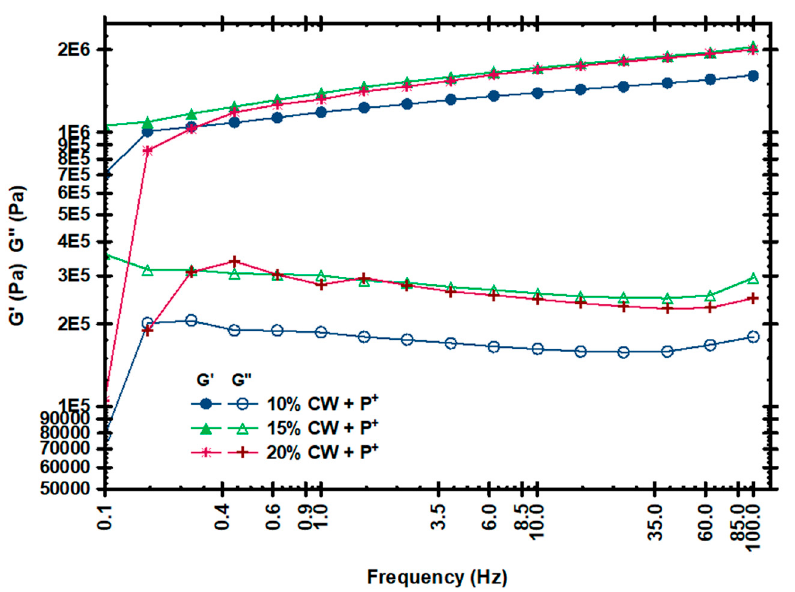
Figure 2. Viscoelastic moduli as a function of the frequency of the oleogels with different concentrations of CW + P + at 40 °C.